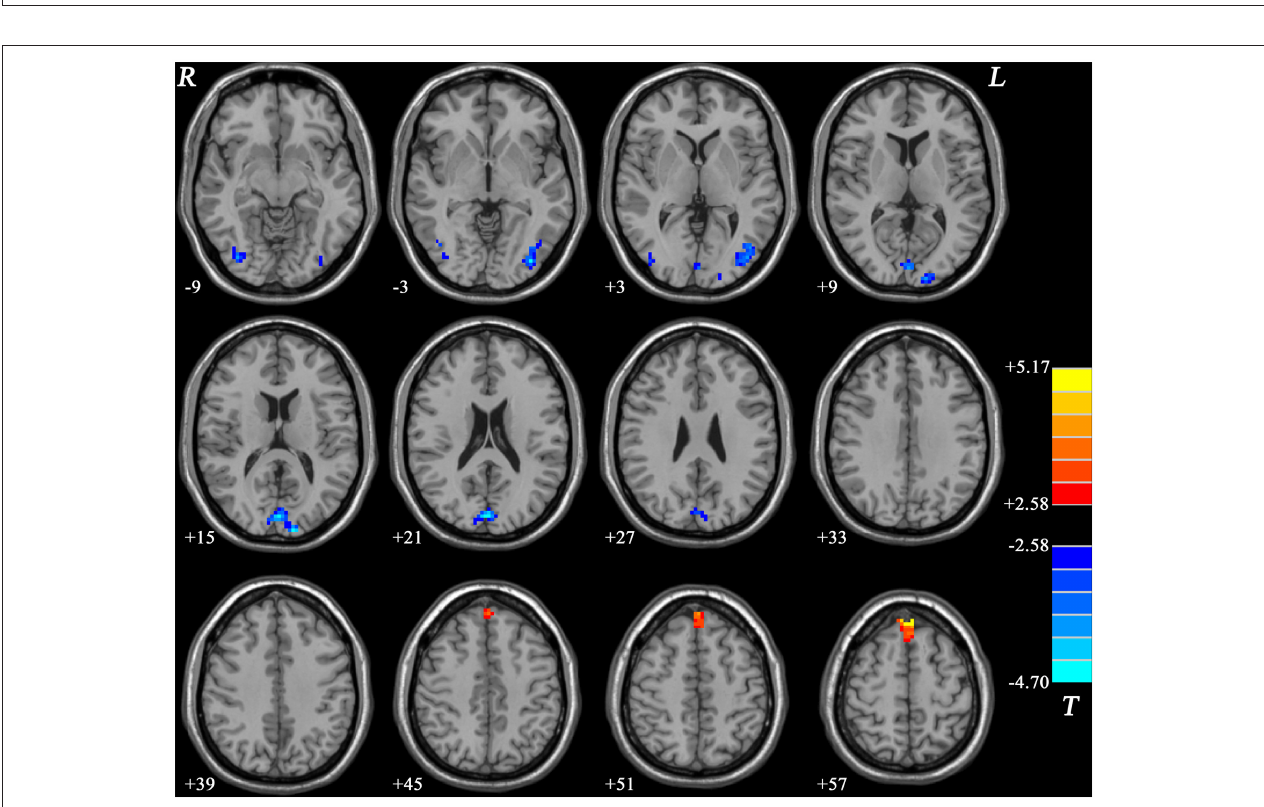
FIGURE 4 | Statistical maps showing the fALFF differences between nGI-MDD patients and HCs. The color bar indicates t values from post-hoc t -tests. Red and blue colors denote increased and decreased fALFF, respectively. fALFF , fractional amplitude of low-frequency fluctuation; nGI-MDD , major depressive disorder without gastrointestinal symptoms; HCs , healthy